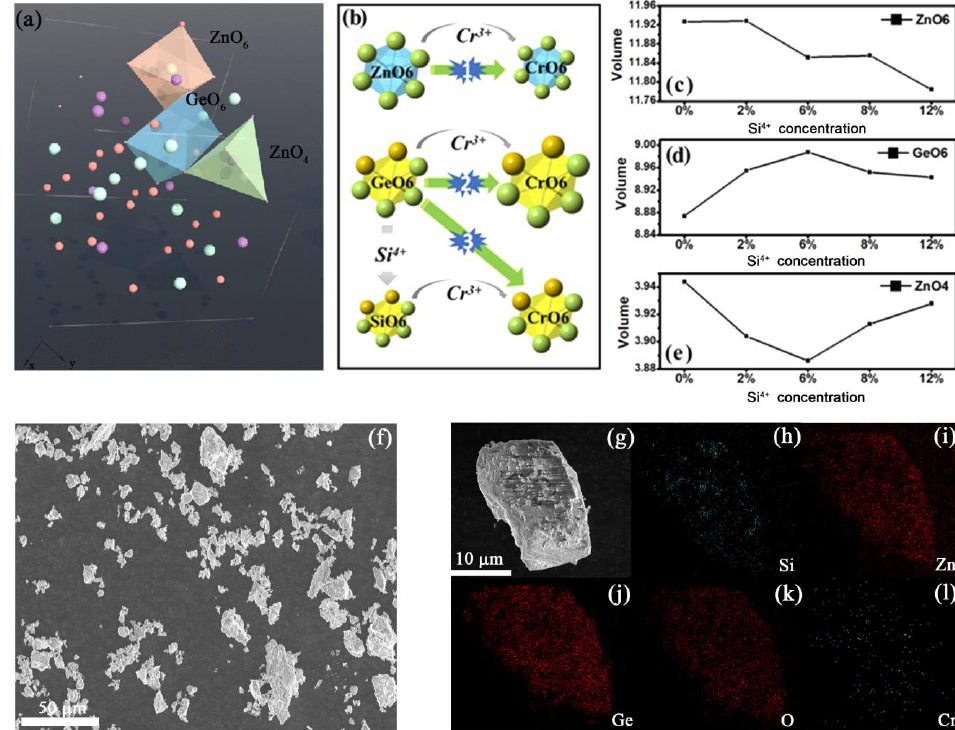
Figure 1. ( a ) Schematic of the crystal structure of LZG; ( b ) simulation diagram of variation trend of each cell volume with the increase in y value in Li 2 ZnGe 3-y Si y O 8 : 0.8%Cr 3+ ; the volume of ( c ) ZnO6 ( d ) GeO6 and ( e ) ZnO4 unit cell in Li 2 ZnGe 3-y Si y O 8 : 0.8%Cr 3+ with increasing y, respectively; ( f ) SEM and ( g – l ) elemental mapping analysis of Li 2 ZnGe 3-y Si y O 8 : 0.8%Cr 3+ .